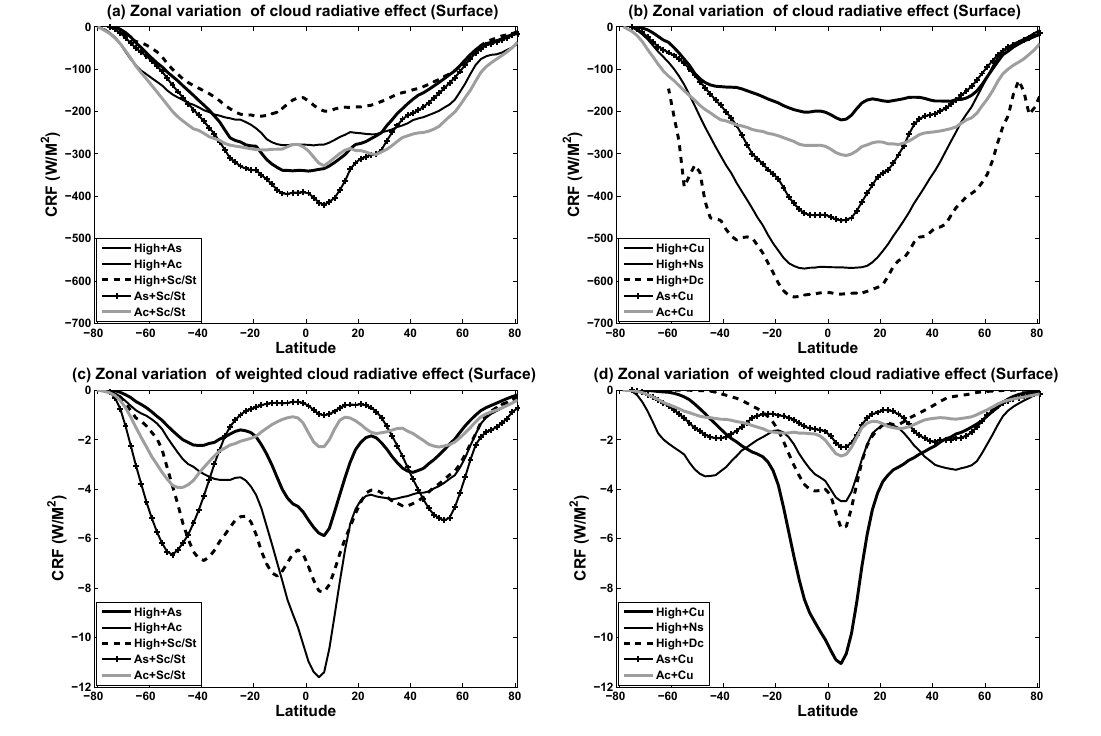
Figure 6. Same as Fig. 5, but at the surface during the daytime.